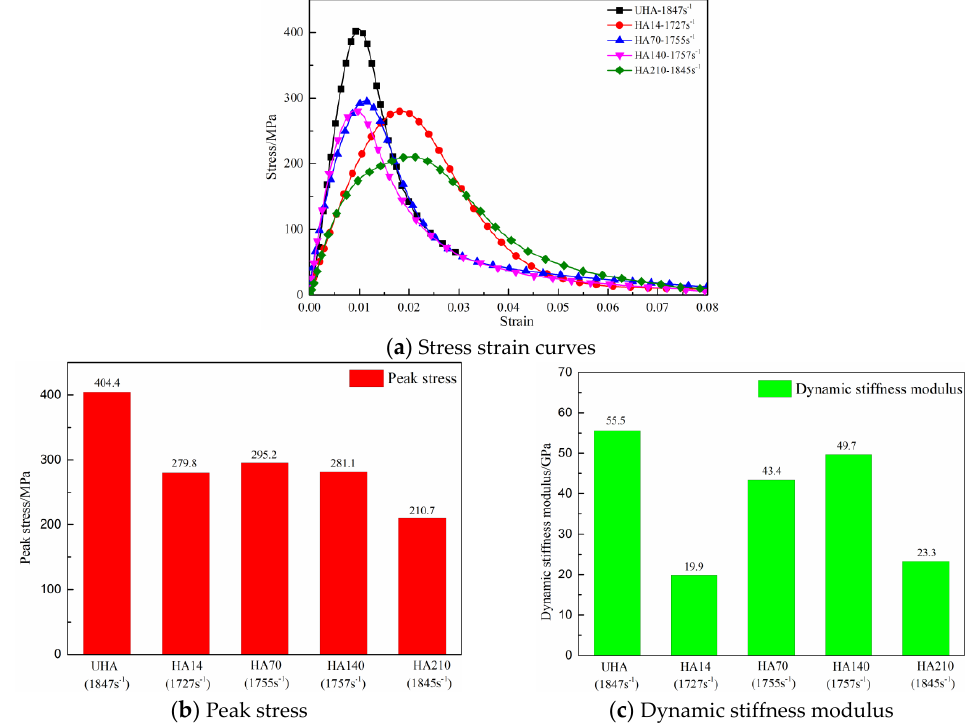
Figure 18. The effect of cyclic hygrothermal aging on the dynamic compressive properties under Figure 18. The e ff ect of cyclic hygrothermal aging on the dynamic compressive properties under 1700~1850 s −1 , ( a ) Stress strain curves, ( b ) Peak stress, ( c ) Dynamic stiffness modulus. 1700~1850 s − 1 , ( a ) Stress strain curves, ( b ) Peak stress, ( c ) Dynamic sti ff ness